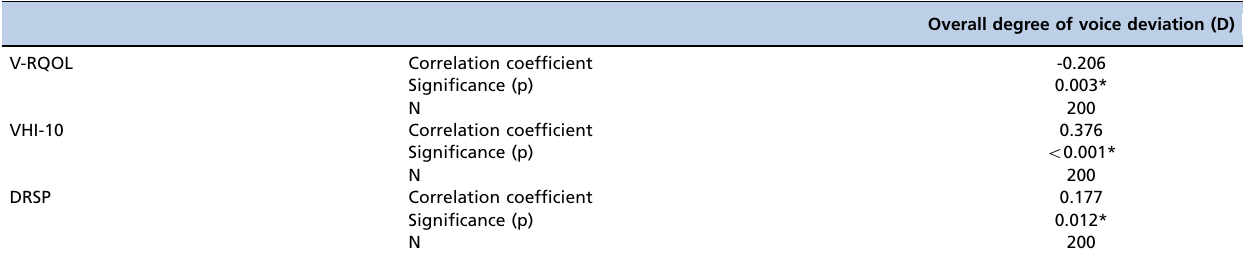
Table 3 - Correlation between D and the V-RQOL, VHI-10, and DRSP.